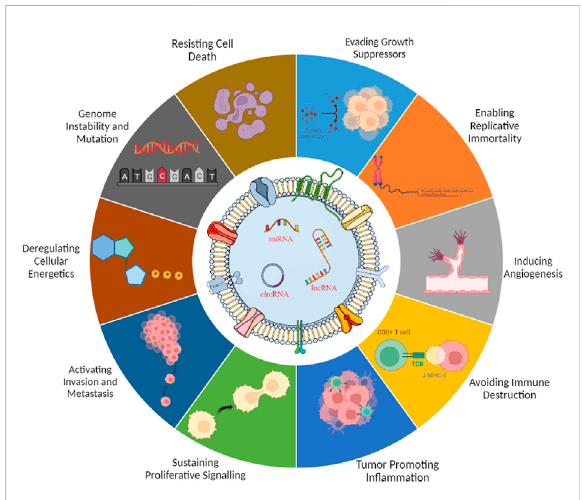
FIGURE 1 Exosomal ncRNAs are involved in the hallmarks of